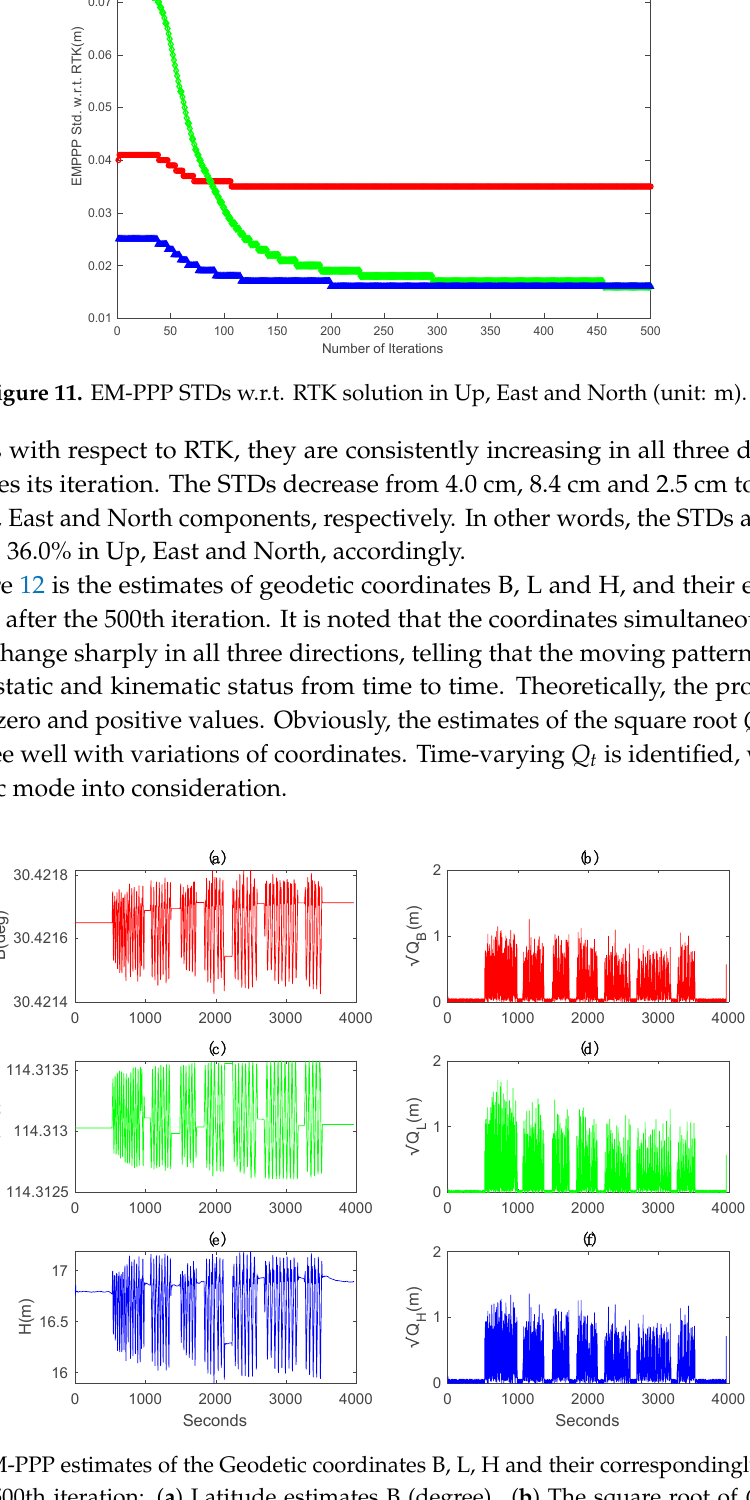
Figure 12. EM-PPP estimates of the Geodetic coordinates B, L, H and their correspondingly calibrated Q t after the 500th iteration: ( a ) Latitude estimates B (degree). ( b ) The square root of Q t of B (m). ( c ) Longitude estimates L (degree). ( d ) The square root of Q t of L (m). ( e ) Height estimates H (m). ( f ) The square root of Q t of H